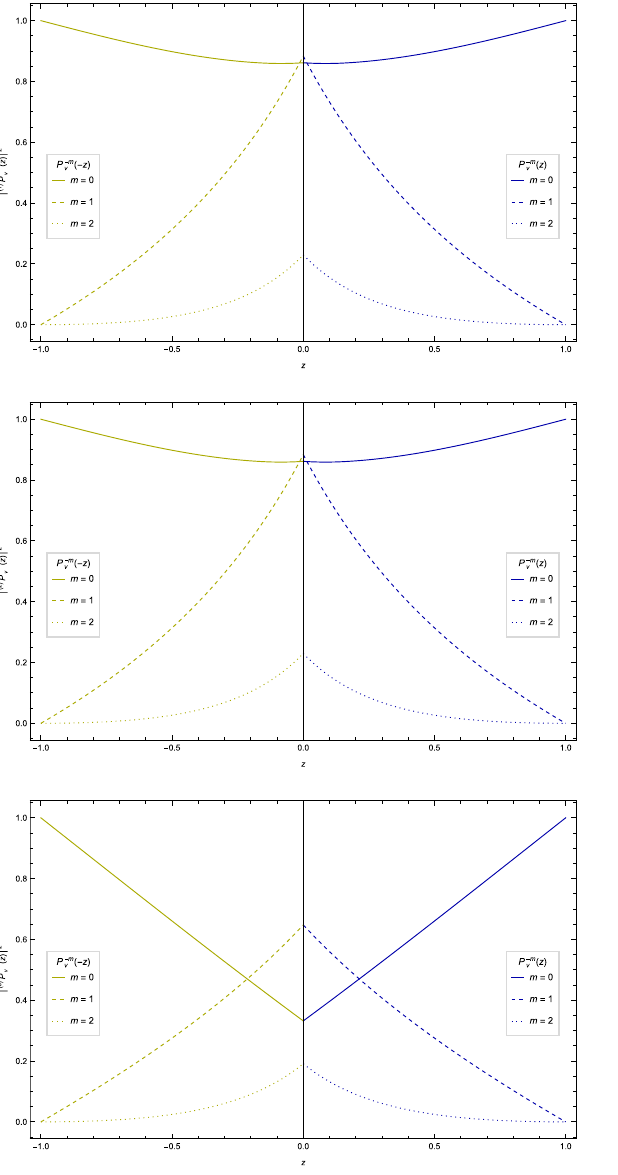
Fig. 6 The squared angular wave eigenfunctions in the Schwarzschild black hole spacetime for the fundamental mode N = 0, where z = cos θ . The units are in multiples of ( j ) C − m ν